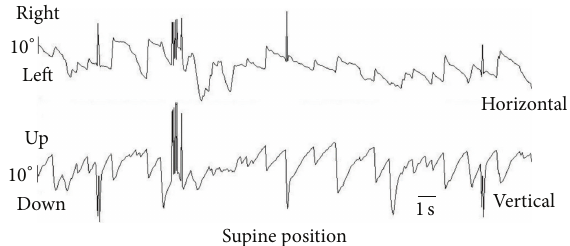
Figure 1: Video-oculographic recording of torsional down-beating nystagmus in the supine position in the head roll test. The vertical component is observed to be down-beating (slow phase velocity 16.5 ∘ /s, 84 beats/min) on the vertical recording. The torsional com- ponent is observed as a horizontal component beating toward the left on the horizontal recording. Video-oculography was performed using the public domain software ImageJ and a Windows computer [10].